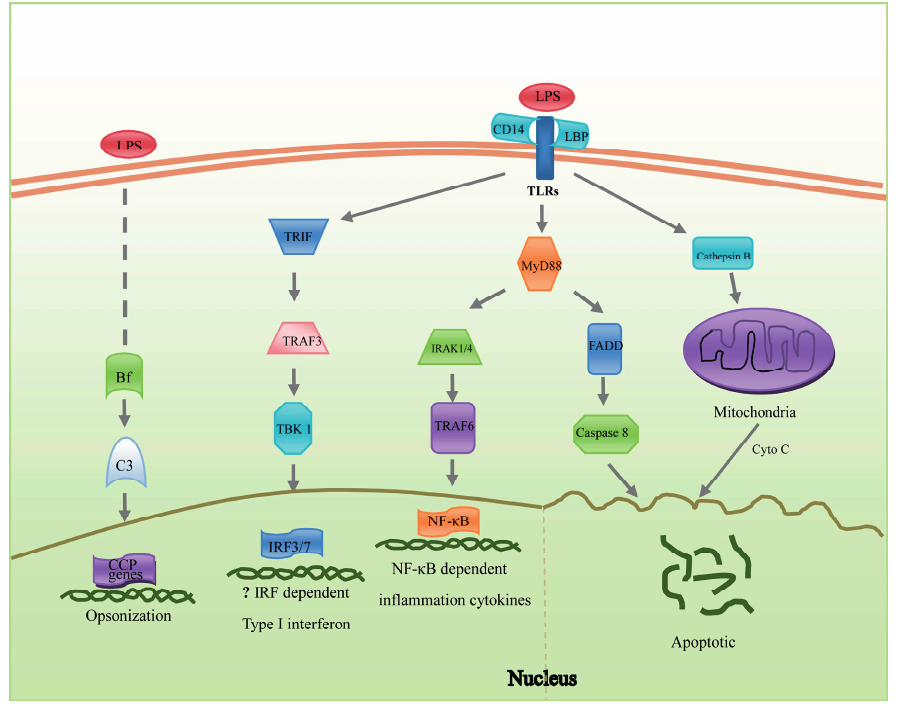
Figure 1. Hypothetical diagram of LPS-triggered inflammation and apoptosis pathways summarized in A. japonicus coelomocytes. Genes listed here play important roles in these potential pathways. On the left, three pathways will promote the expression of inflammation factors. The existence of the Type I type I interferon (IFN) pathway was unclear for the absence of IFN homologues in invertebrates. On the right, the apoptosis pathway will result in the degradation of DNA. The abbreviations: LPS, lipopolysaccharide; CCP, Complement control proteins; TRIF, TLR and interleukin-1 receptor (TIR) domain-containing adaptor inducing IFN- β ; Cyto C, Cytochrome C; TRAF, tumor necrosis factor (TNF)-receptor-associated factor; TBK1, TRAF family member-associated NF- κ B activator (TANK)-binding kinase 1; IRF3/7, interferon regulatory factor 3/7; CD, cluster of differentiation; LBP, lipopolysaccharide binding protein; TLR, toll-like receptor; MyD88, myeloid differentiation primary response gene 88; FADD, Fas-associated death domain protein; IRAK1/4, interleukin-1 receptor-associated kinase 1/4; NF- κ B, nuclear factor- κ